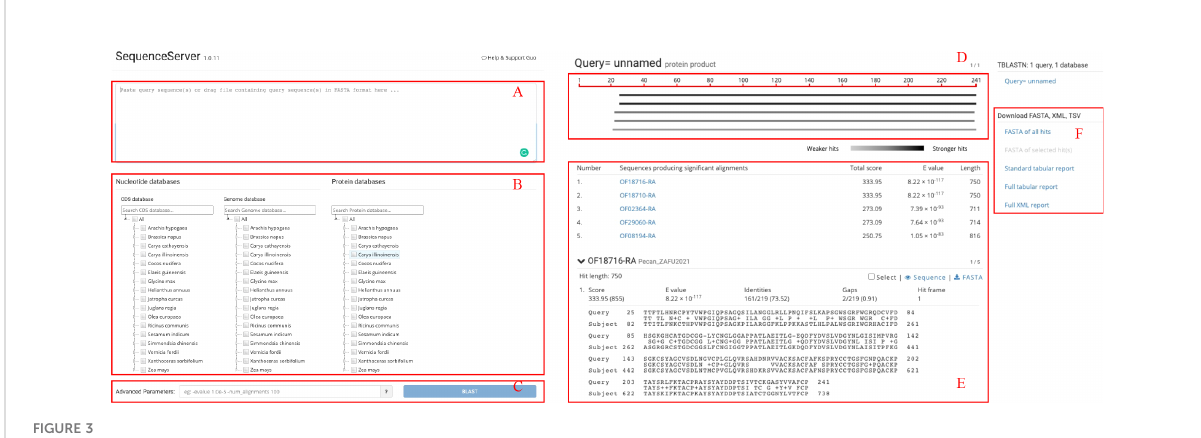
FIGURE 3 BLAST interface of GROP. (A) Query sequence input box for the BLAST program. (B) Search databases containing nucleotide and protein sequences. (C) BLAST advanced parameter input box. (D) Visualized BLAST alignment map. (E) Detailed BLAST result information. (F) BLAST results for